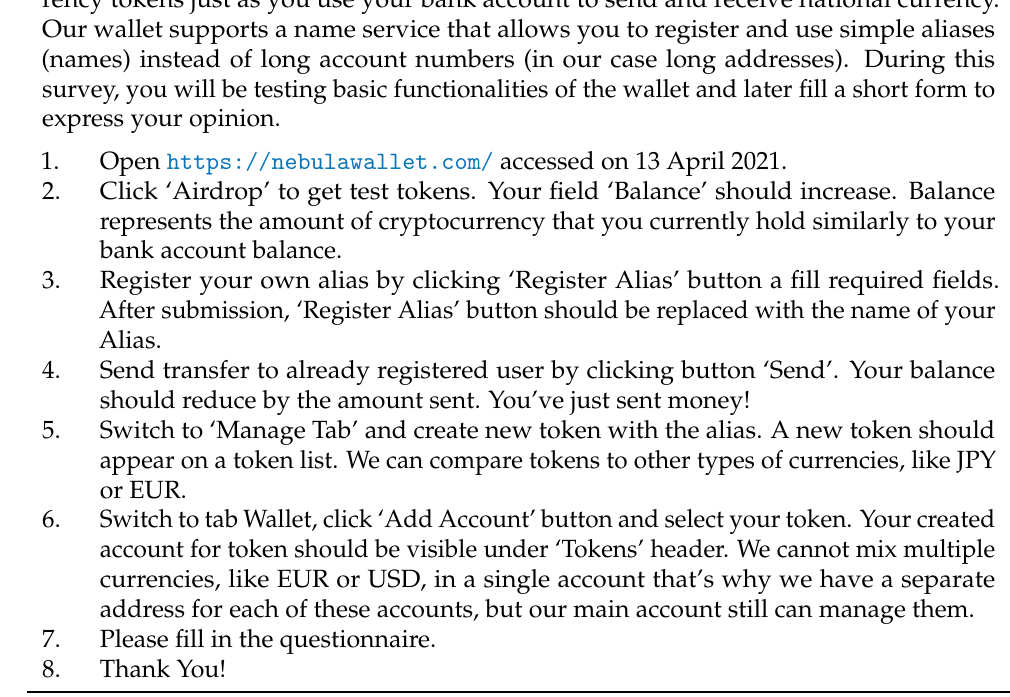
Table A1. User evaluation